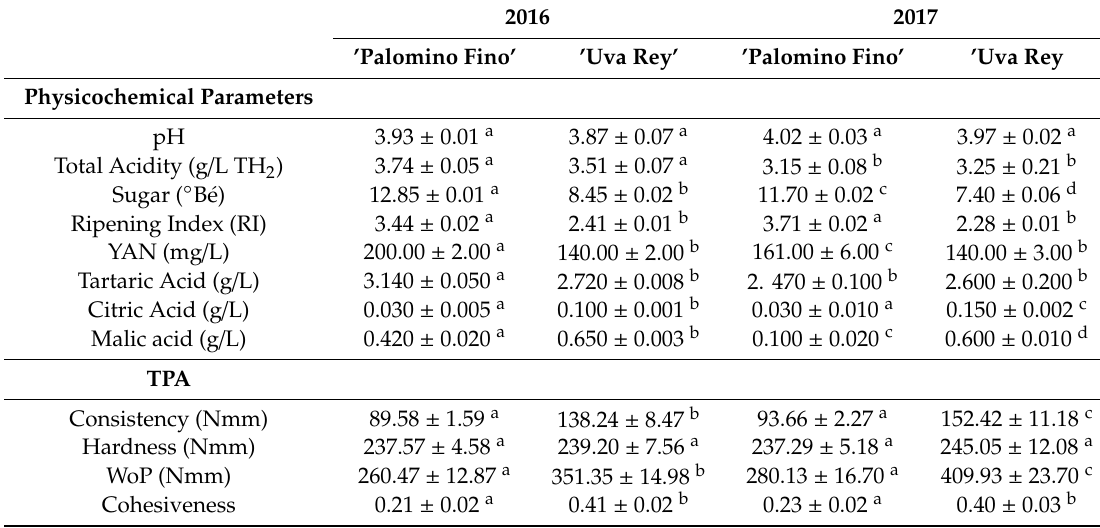
Table 3. ’Uva Rey’ and ’Palomino Fino’ grape berry texture profile analysis (TPA) and must